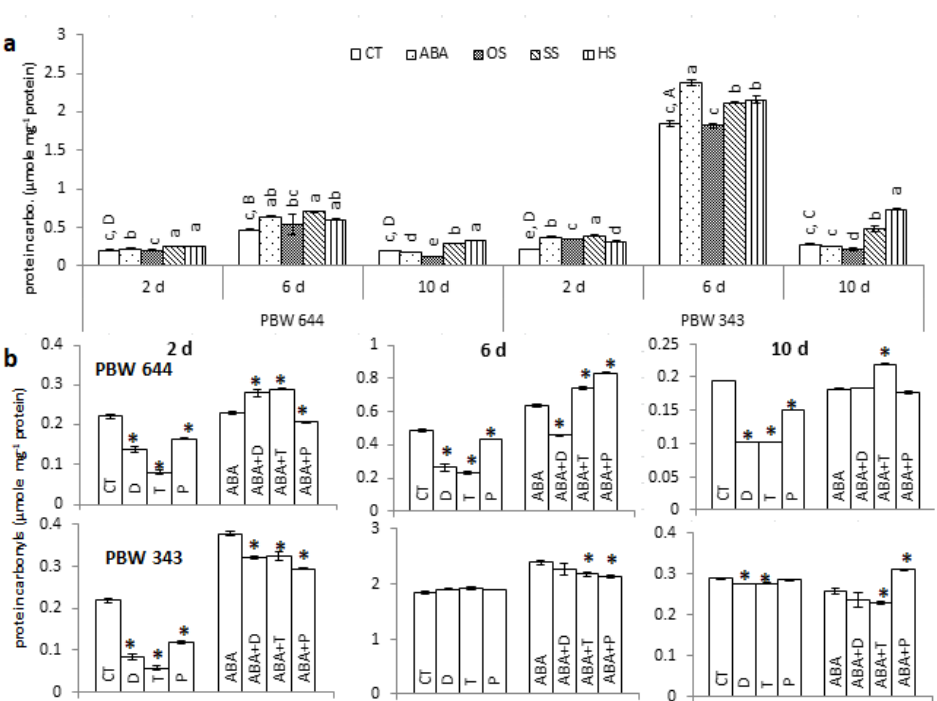
Figure 5 - Change of protein carbonyls ( a ) and ROS/NO regulation of protein carbonyls ( b ) during post- germination desiccation and rehydration of wheat cultivars PBW 644 and PBW 343. Rest is same as in Fig. 1 for a and Fig. 2 for b